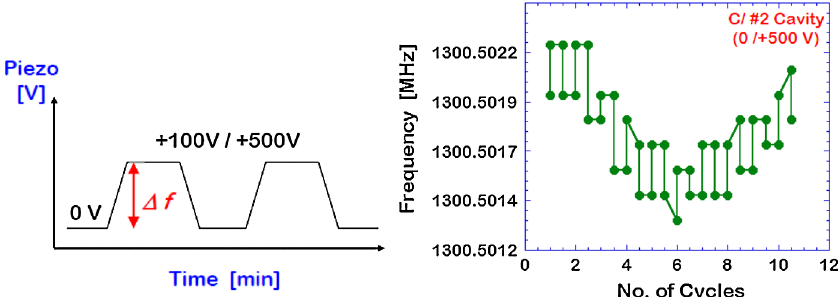
FIG. 14. (Color) Measurements of reproducibility of frequency changes by applying repeated step voltage to piezo tuner: The left figure shows an applied piezo voltage with a repeated step pattern (one cycle represents approximately 10 min.). The right figure shows the change in the resonant frequency from applying a piezo voltage between 0 and þ 500 V in #2